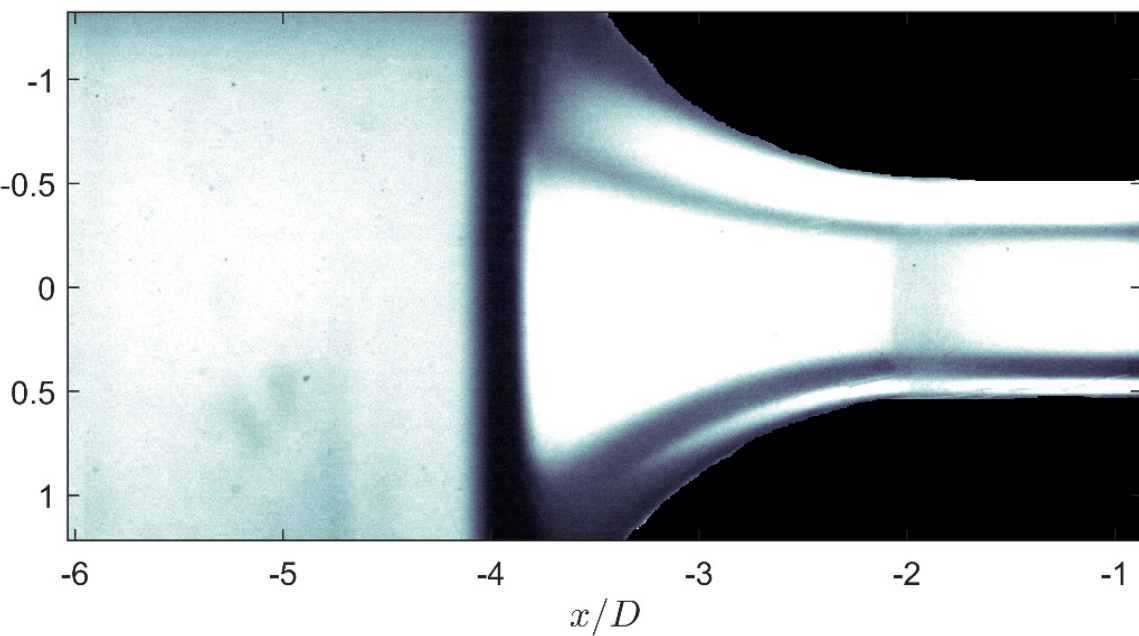
Figure 4. Image of the orifice inlet.